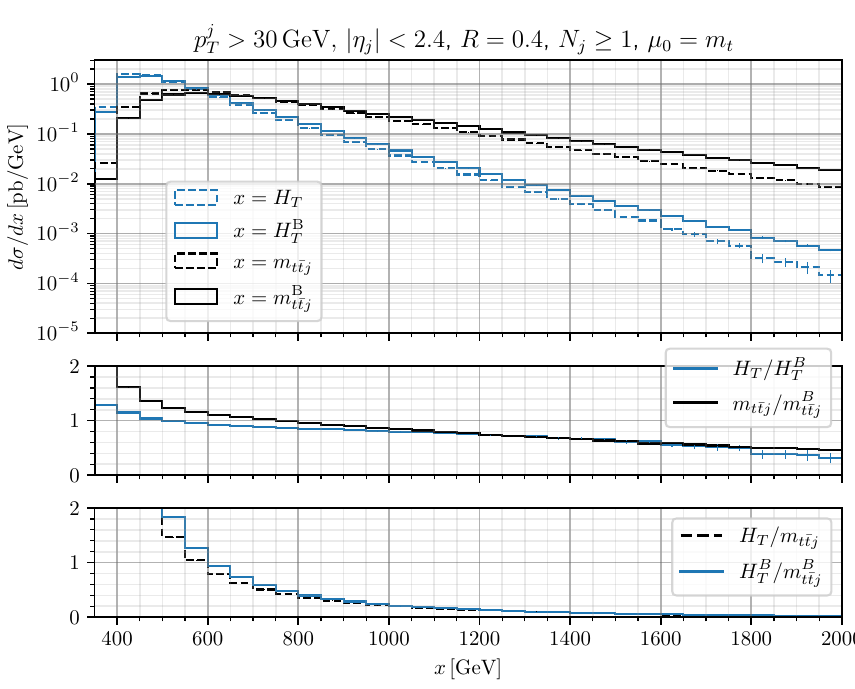
Figure 2 . Differential cross section as a function of H B solid) and m (black dashed), calculated for the pp → t ¯ tj + X process at a center of mass energy t ¯ tj √ of S = 13 TeV, using as input a central scale µ 0 set to µ 0 = m t